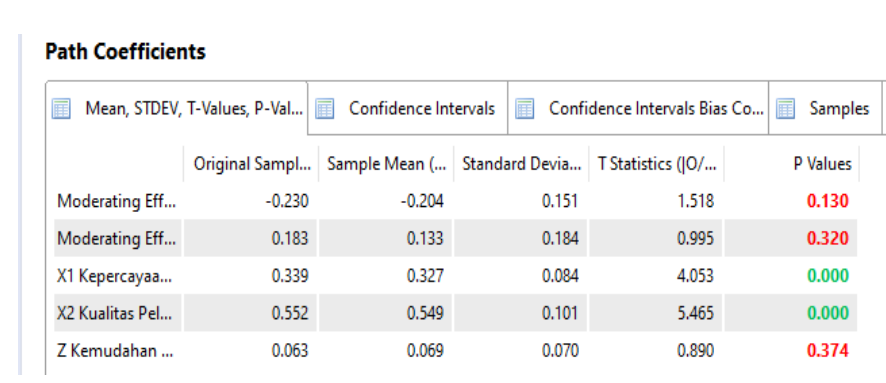
Figure 4. Gambar Path Coefficient